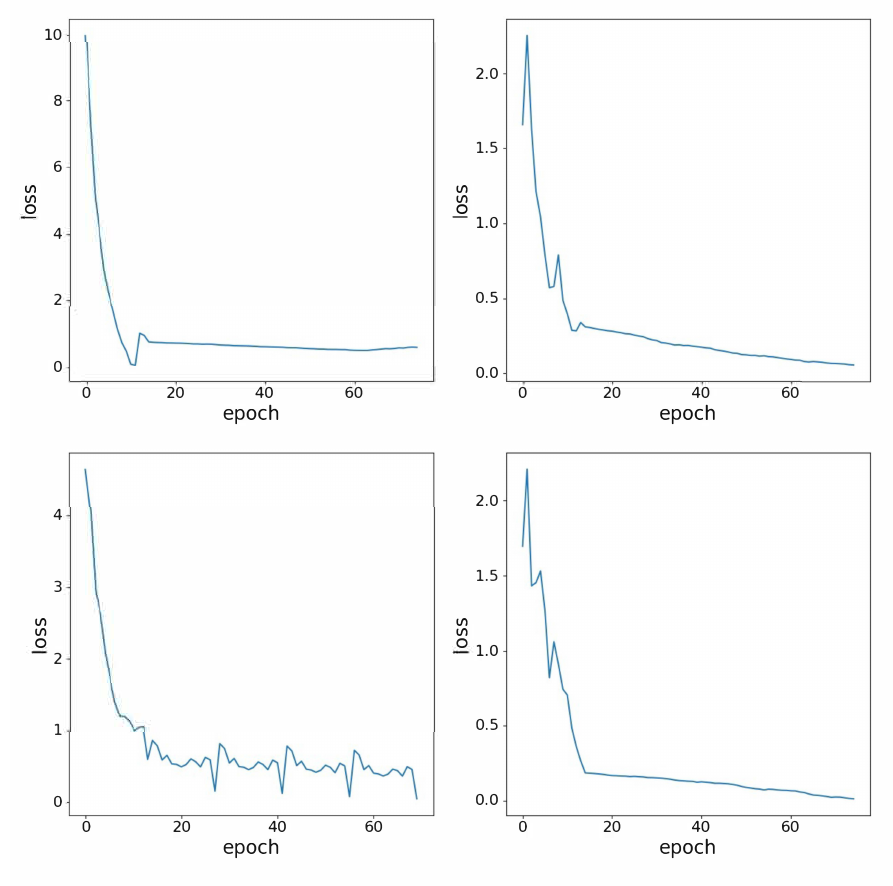
Figure 6. Training losses of